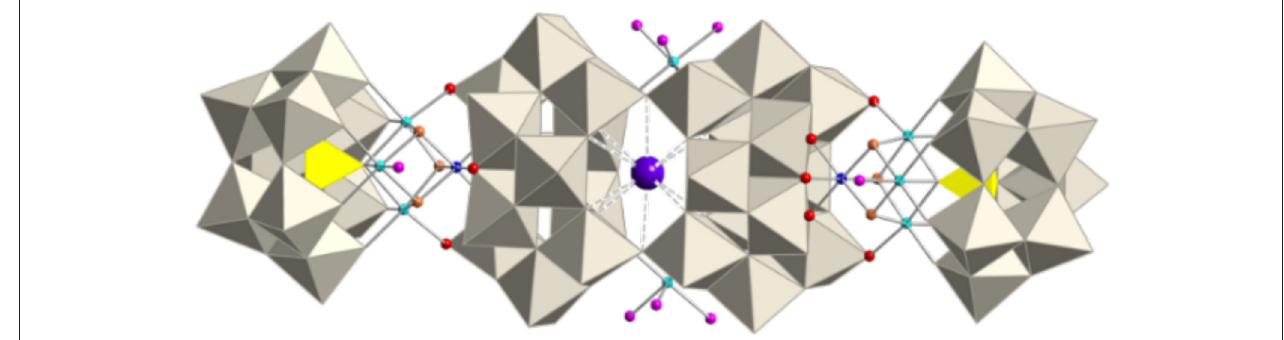
FIGURE 4 | Polyhedral and ball-and-stick representation of the [{Co 4 (OH) 3 (H 2 O)(PW 9 O 34 )} 2 {K ⊂ (H 2 W 12 O 41 ) 2 }{Co(H 2 O) 4 } 2 ] 17 − polyoxoanion ( 4 ). Grey octahedra, {WO 6 }, yellow tetrahedra; {PO 4 }, cyan spheres; Co II , blue spheres; Co III , red spheres; O, orange spheres; OH, pink spheres; H 2 O, violet sphere, K.